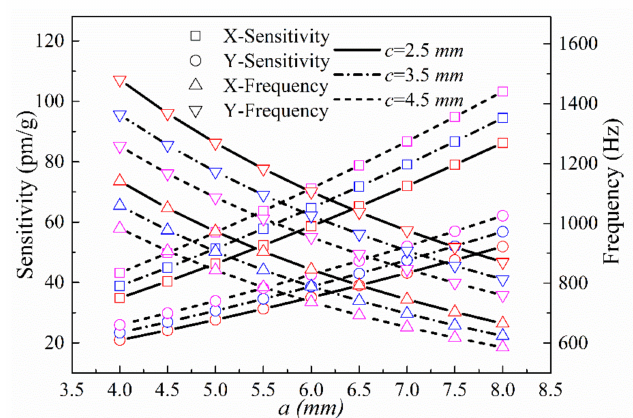
Figure 12. Sensitivities and natural frequencies in the x- and y-directions as a function of a at different values of c